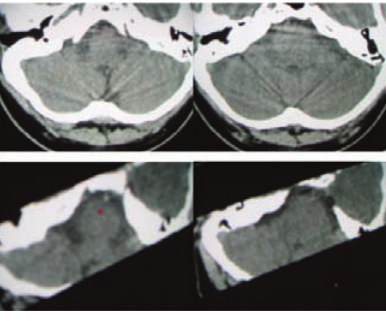
Figure 4. Improved clarity of brainstem anatomy with sagittal oblique technique on axial reformatted images on a spiral CT scanner (GE Synergy, USA). Top row: using 2 mm thin slices (the thinnest possible col- limation on this spiral CT scanner, with 2 mm thin reconstructions, the lowest on this CT scanner) in the posterior fossa, the brainstem and surrounding cisterns are obscured by artifacts. Bottom row: 2 mm axial reconstructions after acquisition with 2mm sagittal oblique scans now show the brainstem, basilar artery and surrounding cisterns with great clarity. All exposure fac- tors were the same in both the spiral-axial and spiral-sagittal oblique techniques: 120 kVp, 100 mA, pitch=1, table speed 2 mm/sec, slice thickness=2 mm.